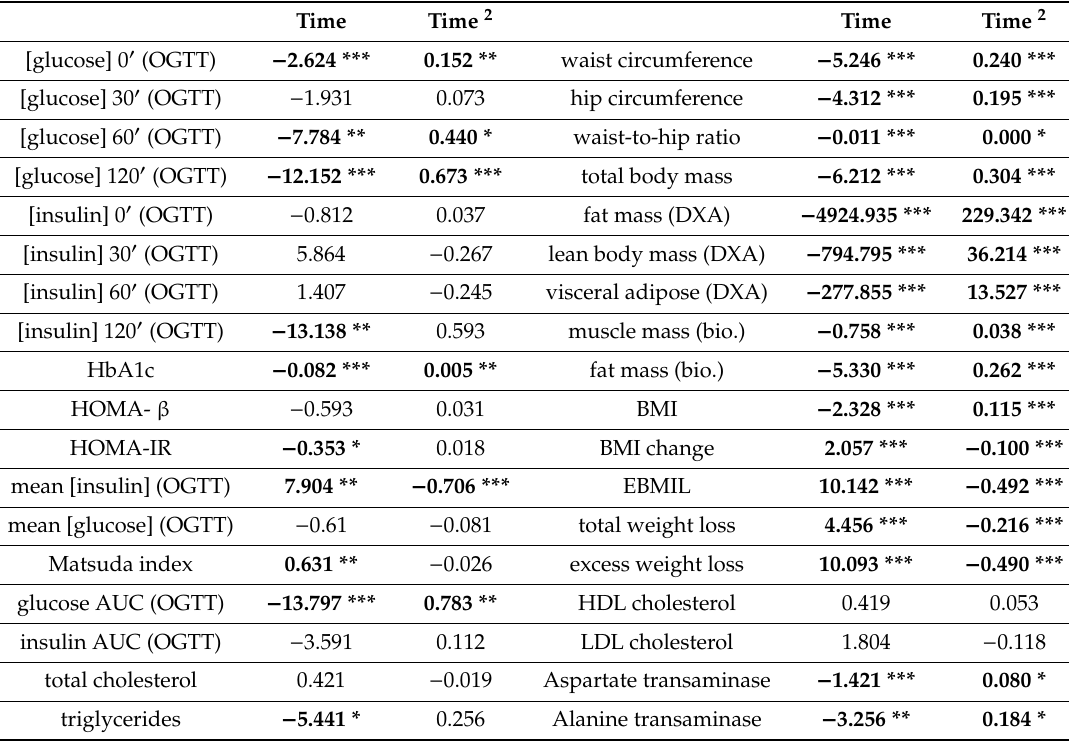
Table 3. Time coefficients from GLMMs and significances adjusting for age, sex, diet, and physical activity.